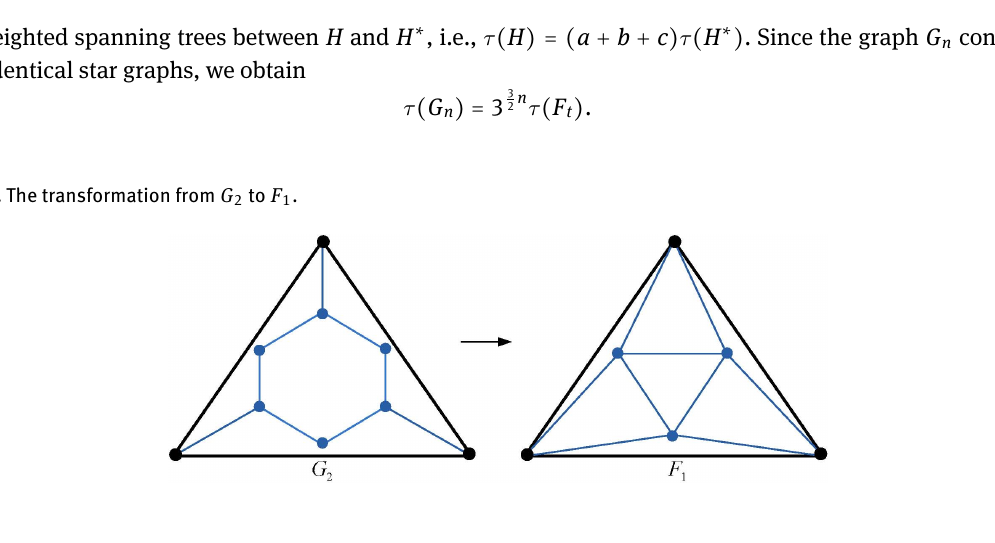
Fig. 3. The transformation from G 3 to F ∗